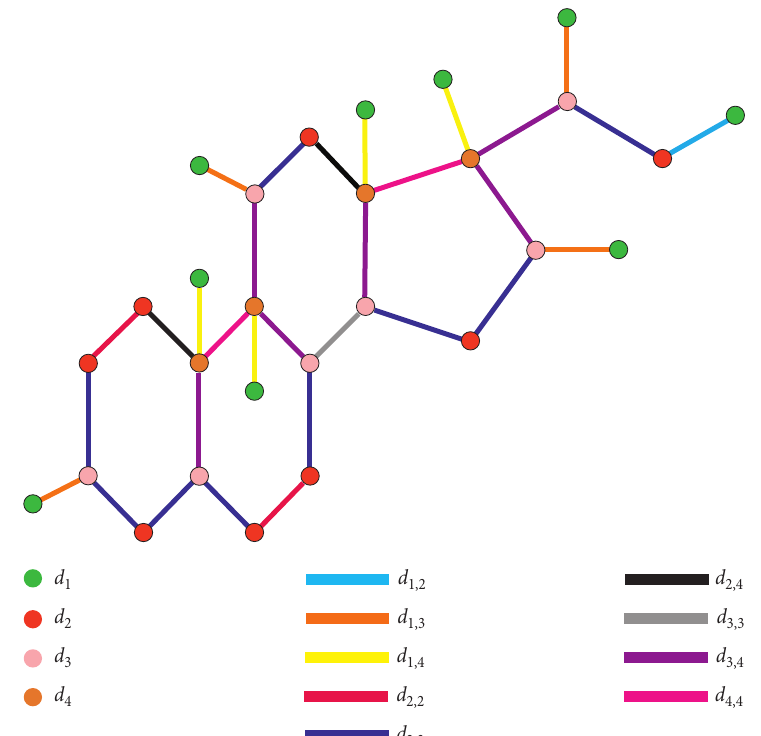
Figure 2: Chemical graph of dexamethasone ( D Table 1: Vertex partition of D